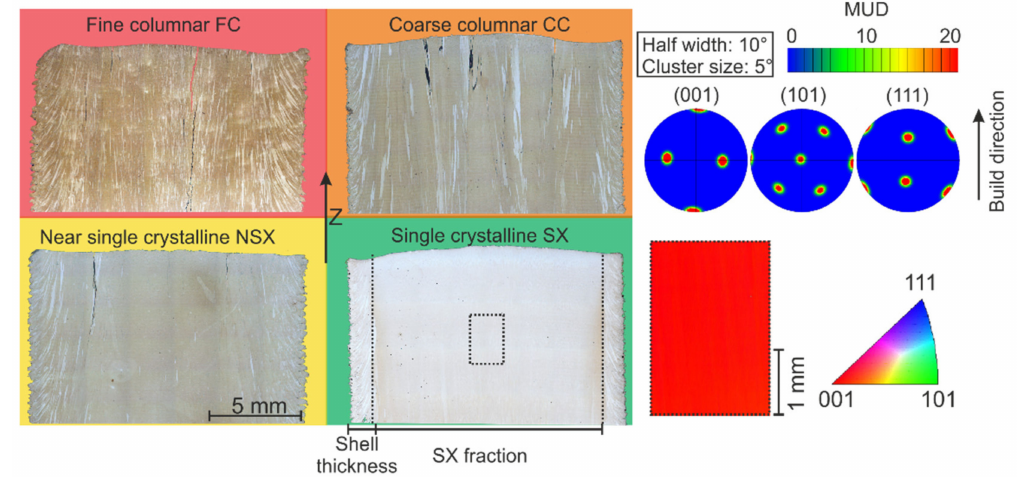
Figure 1. Microstructure classification: Fine columnar (FC), coarse columnar (CC), near single crystalline (NSX) and single crystalline (SX). The dashed rectangular area marks the area of the EBSD measurement, to verify the present single crystal